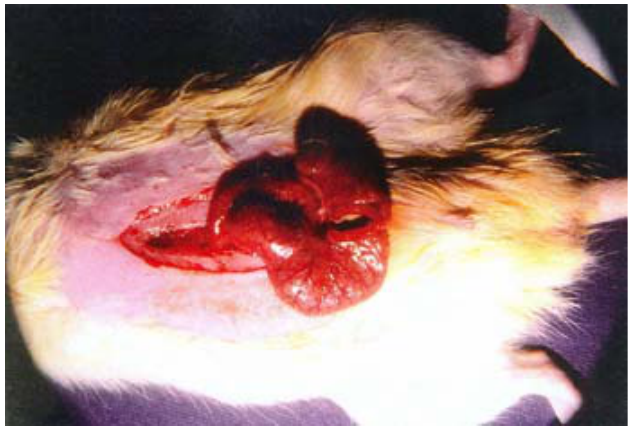
FIGURE 1 – Surgical aspect of